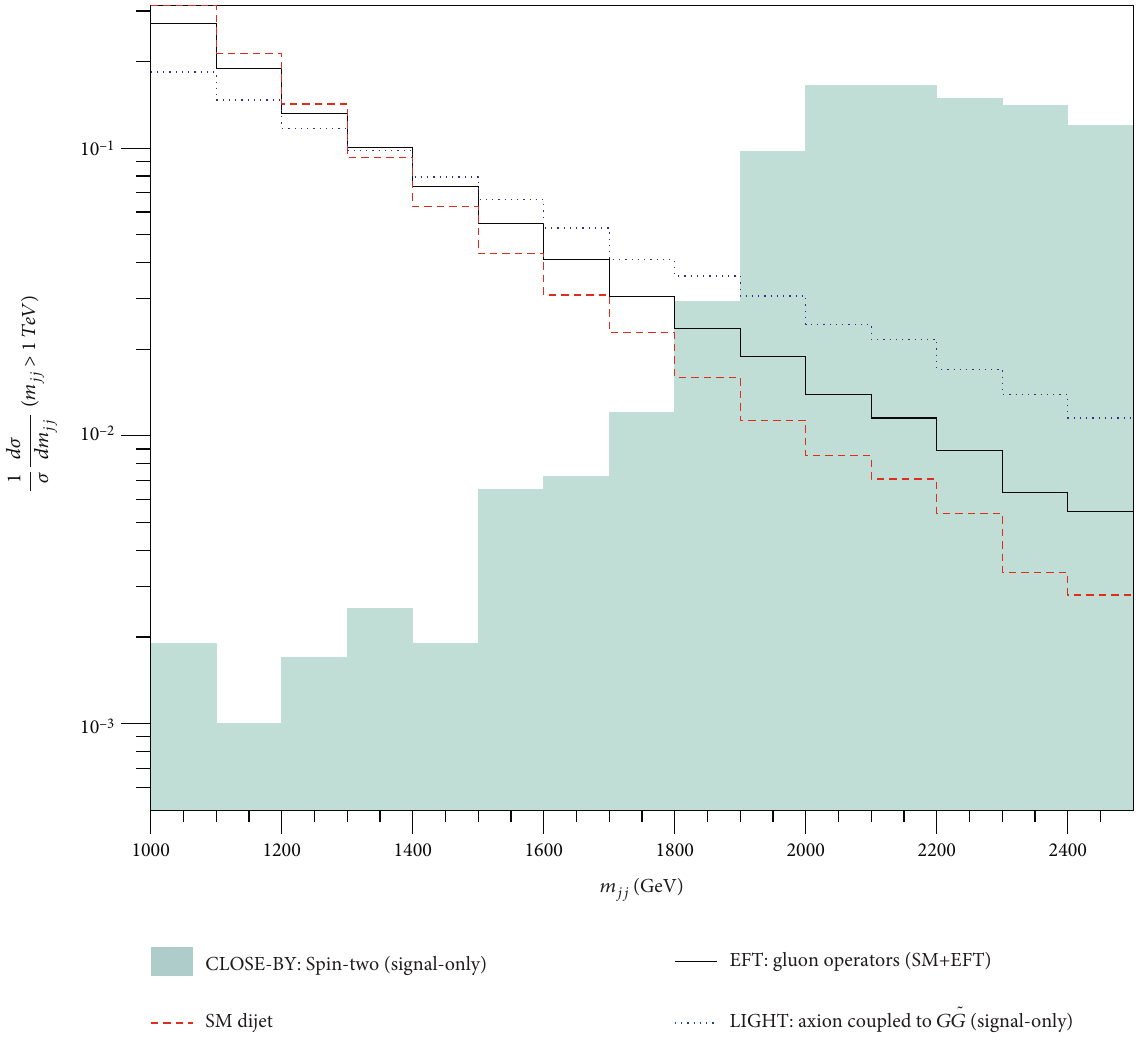
Figure 9: The m di ff erential distribution in the SM, EFT, axion-like, and broad resonance jj